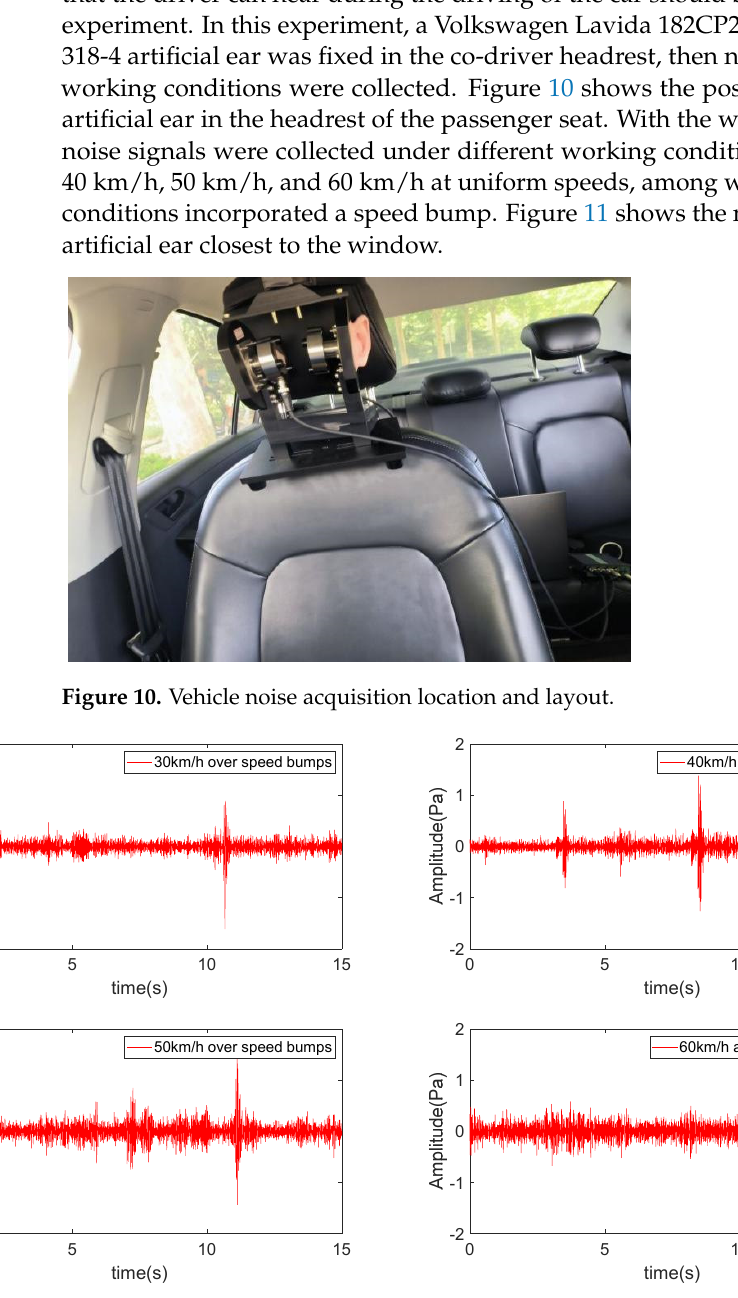
Figure 11. Real-time vehicle noise signal acquisition.